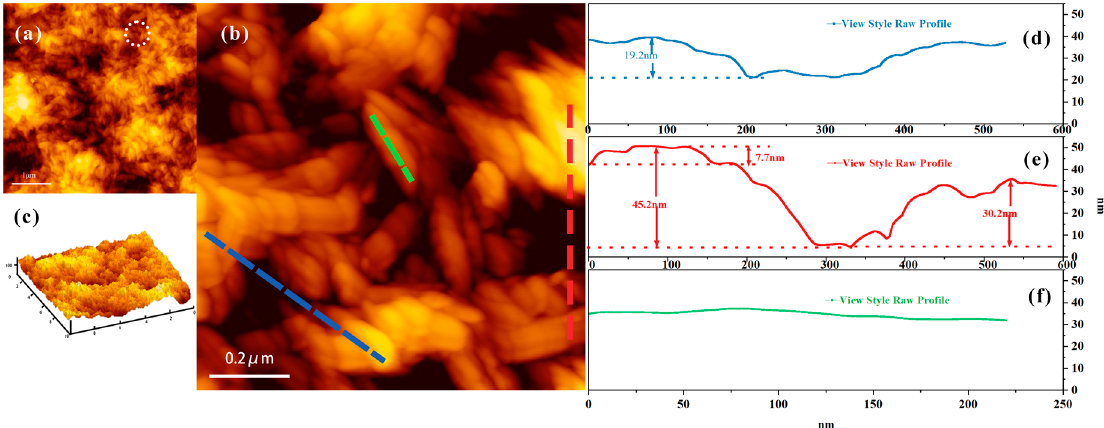
Figure 2. AFM morphology of CNC and the cross section of the fiber. (( c ) is 3D image of CNC film. ( d – f ) are the length and section height data of the corresponding color line segment in C respectively. The three line segments of red, yellow and blue are randomly selected, and the height difference of the surface of nano cellulose film is measured).